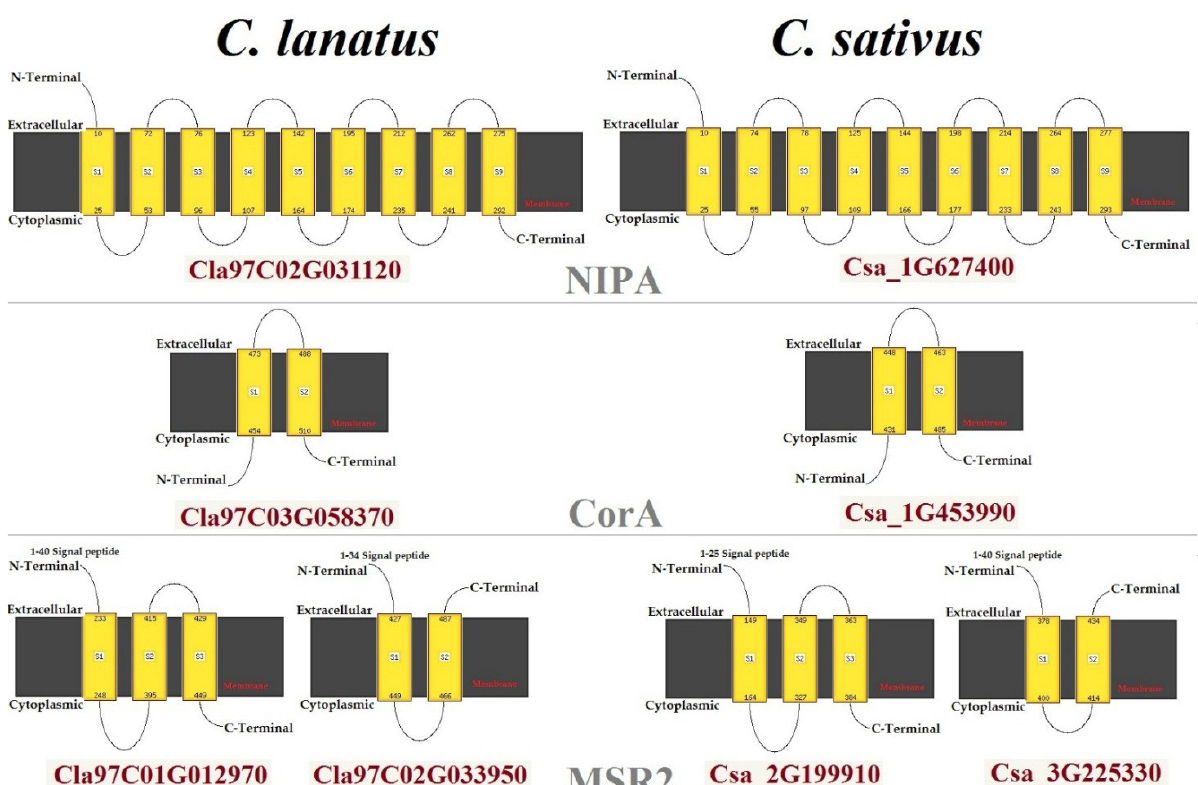
Figure 4. Percentage of amino acids in the predicted pocket sites of MGT proteins in C. lanatus and C. sativus .